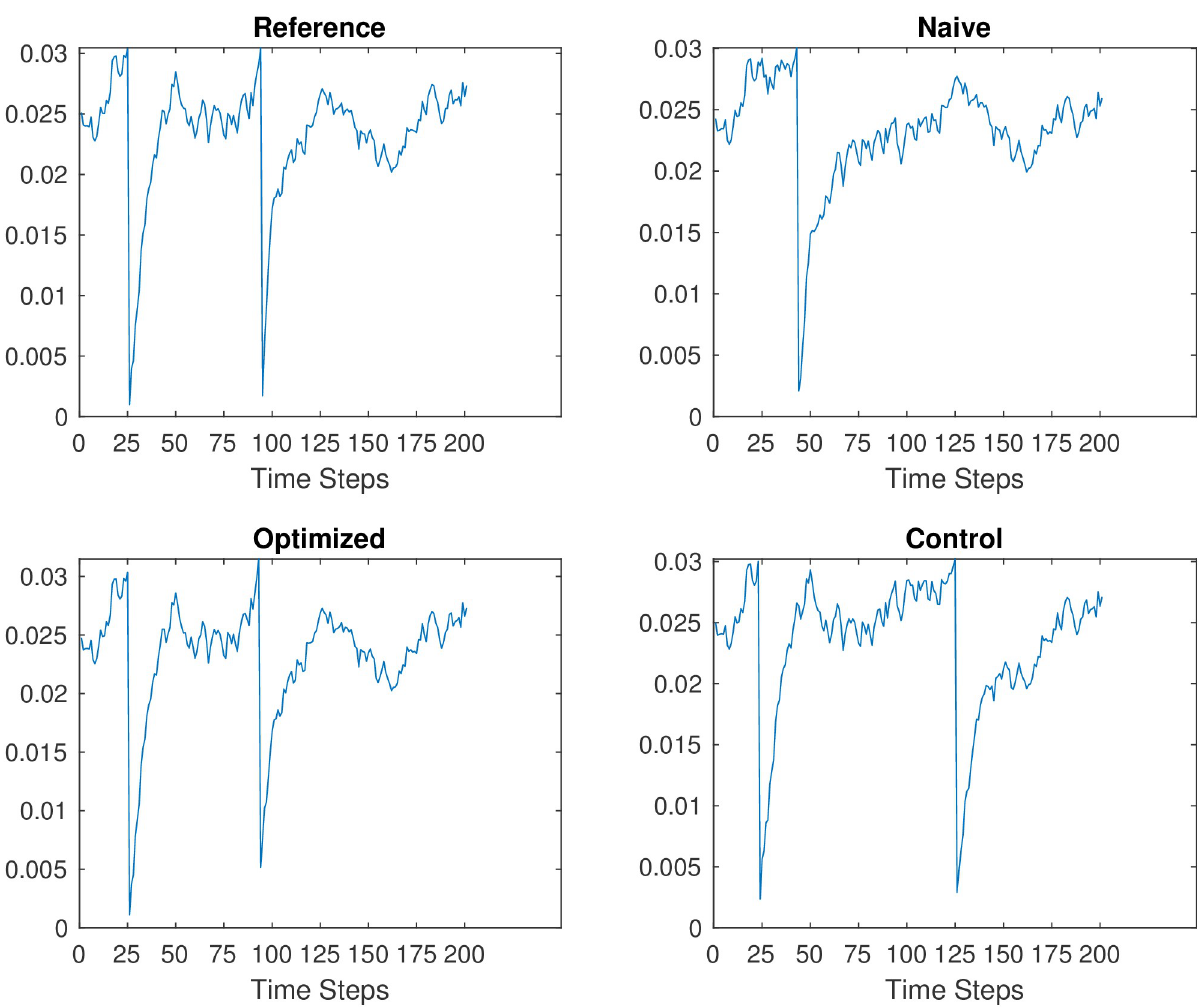
Fig 9. PSPM used to generate a LIF network operating near criticality. ( A ) Scaling relations for the avalanches of the PIF outputs. The size (left) and duration (middle) distributions of the avalanches present in the PIF outputs (Methods). Data is presented in log-log plots so that the empirically fit power laws are clear. The critical exponents for the size τ = 1.242 and duration α = 1.327 are fit through regression and used to predict a theoretical value for the scaling constant β p = 1.351 between average avalanche size < S > and duration D . An observed value β o = 1.351 is obtained through regression on the avalanche data. The predicted and observed values for the critical exponent β , a measure of the criticality of a system, agree reasonably well with a difference of | β o − β p | = .006, indicating that the spike trains exhibit criticality. This is unsurprising given that the PIF’s weight matrix had its maximum eigenvalue tuned to 1 (Methods). ( B ) The outputs of a na ï ve network with uniform initial network characteristics failed to exhibit criticality, with both size and duration distributions deviating significantly from power laws. ( C ) After optimization, the size and duration distributions follow power laws with impressive agreement between predicted and actual critical exponents | β | = .064. ( D ) The control condition, however, also o − β p demonstrates a reasonable approximation of criticality albeit with larger disagreement between predicted and fit β : | β o − β p | = .128. This suggests that synaptic scaling without neuron-by-neuron precision weight changes may be sufficient to generate criticality in an LIF network.